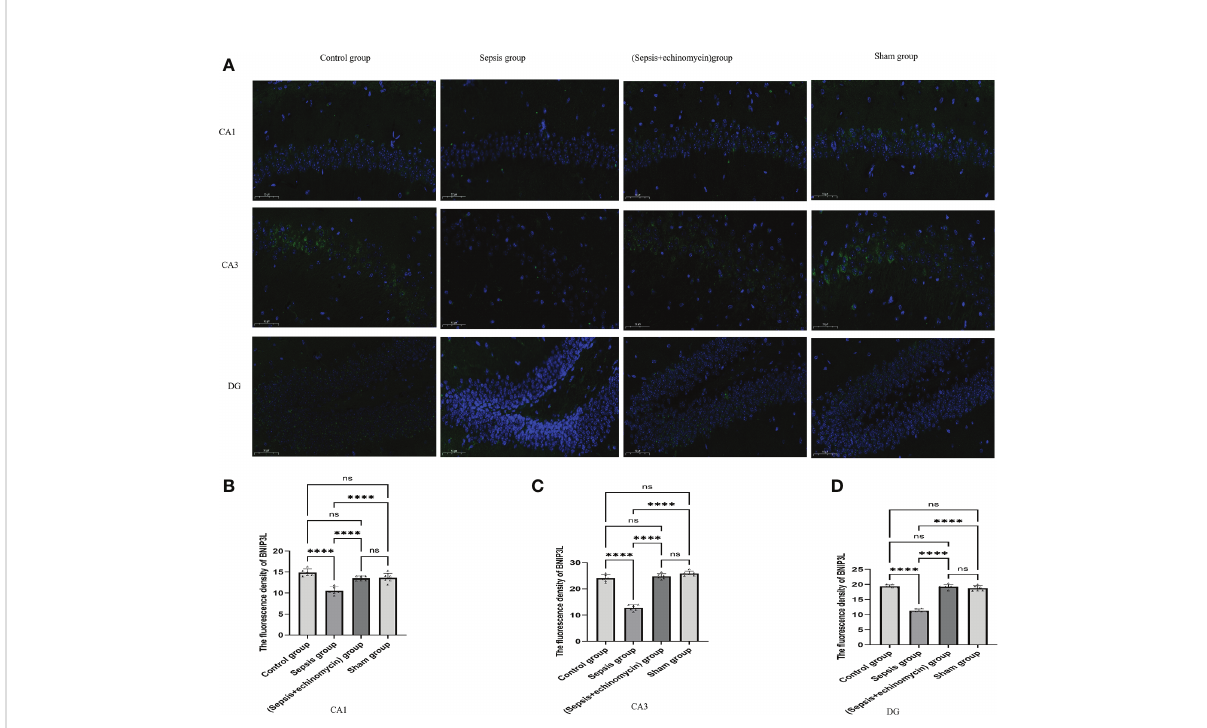
FIGURE 7 Immuno fl uorescence detection the BNIP3L expression of hippocampus tissue CA1, CA3 and DG area (A) .The average nuclear BNIP3L fl uorescence density of hippocampus in three fi elds of view per slice was analyzed in each group by the ImageJ software (B – D) . Compared with other three groups, sepsis down-regulated BNIP3L expression in the hippocampus of mice.****: p < 0.0001, ns: p >